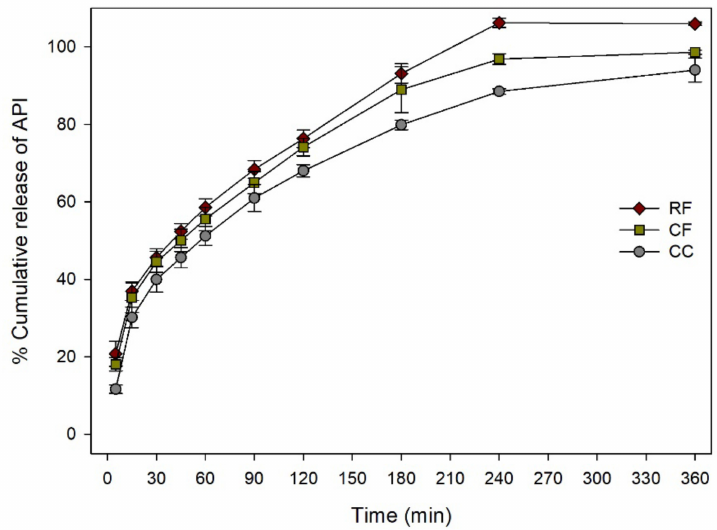
Figure 12. Dissolution rate of floatable combined solid dosage forms in pH 6.8 phosphate bu ff